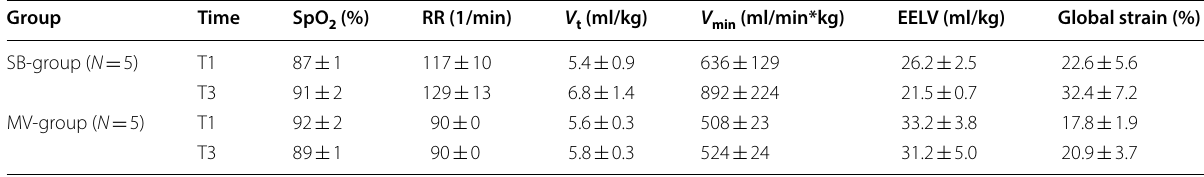
EELV, V min , V t , and global strain were obtained from image analysis of μ-CT images No significant changes were detected between T1 to T3 in any of the groups